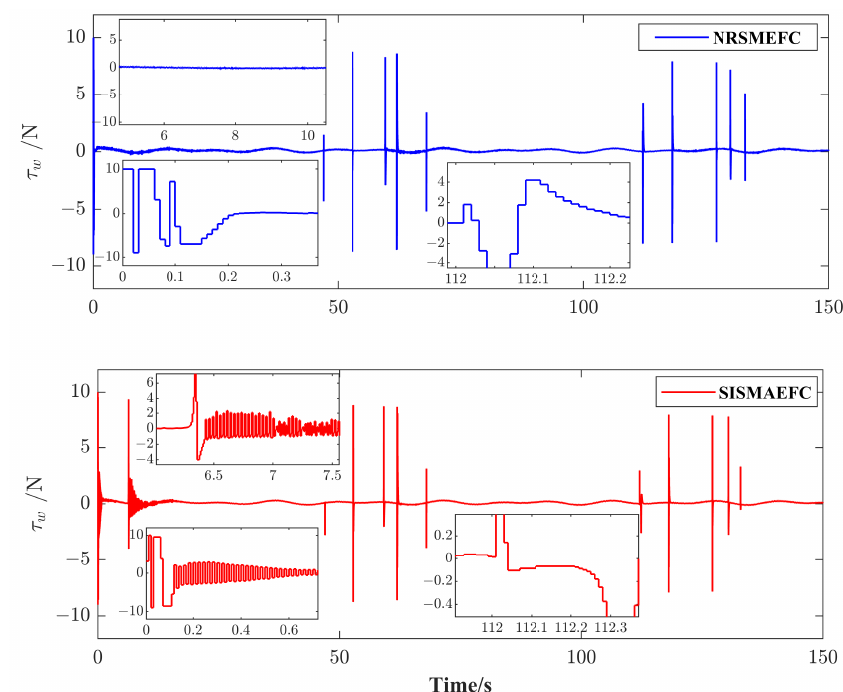
Figure 10. Differential coupling input τ w